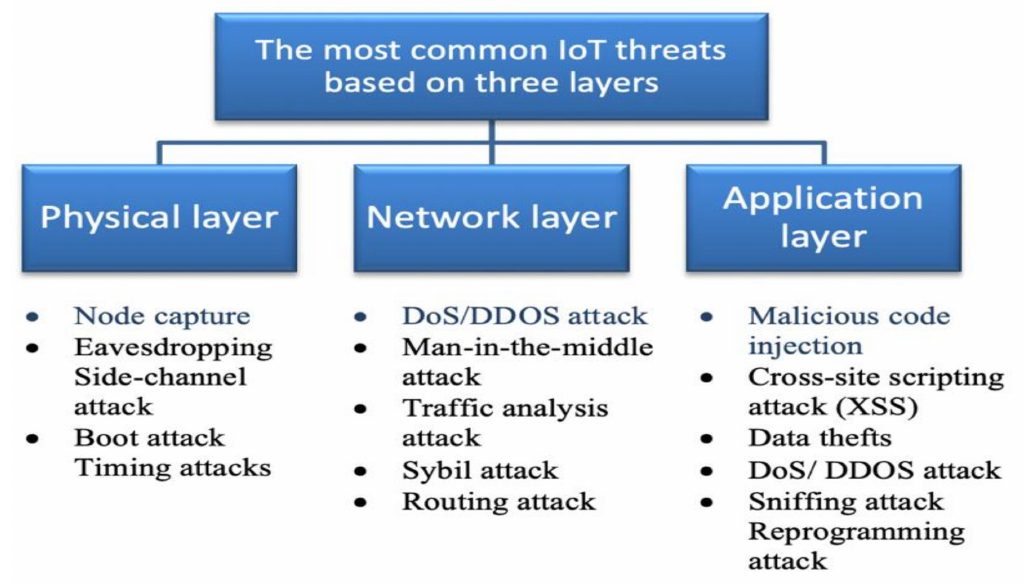
Figure 8. Common threats in the application layer. Based on three layers of IoT architecture, Figure 9 illustrates the most common threats. The layers are the physical layer, the network layer, and the application layer.